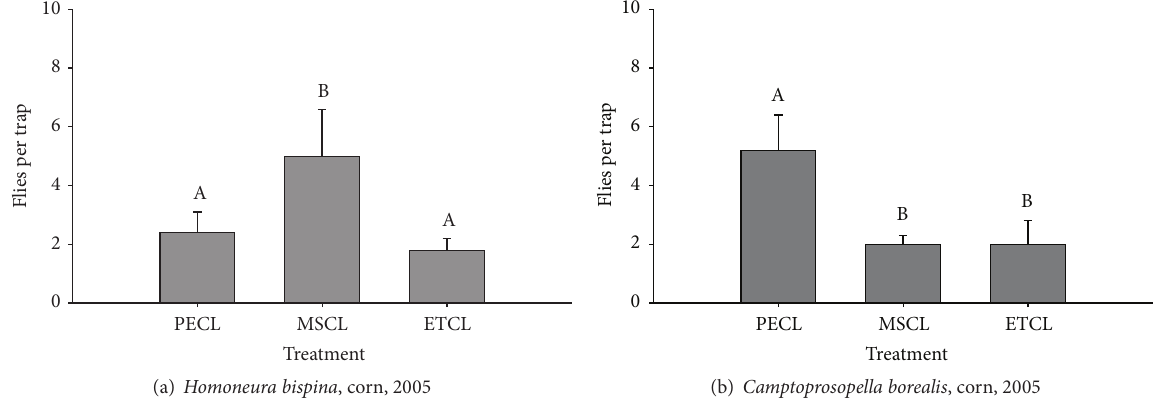
Figure4:Numberoflauxaniidfliesperstickytrap( ± SE)baitedwith2 mgincontrolled-releasedispensersofethanol(control)=ETCL,methyl salicylate = MSCL, or 2-phenylethanol = PECL in corn plots near Brookings, SD, Jul 13–15, 2005 (test #5). (a) Adult Homoneura bispina ; (b) adult Camptoprosopella borealis . For each species, bars without the same letter above them indicate that the means differ significantly.